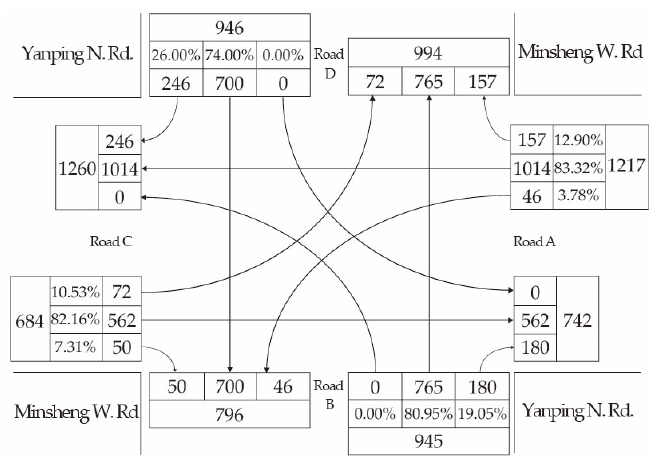
Figure 8. Road traffic data from 5:00 p.m. to 6:00 p.m. on Minsheng W. Rd. and Yanping N. Rd. Figure 8. Road tra ffi c data from 5:00 p.m. to 6:00 p.m. on Minsheng W. Rd. and Yanping N. Rd.